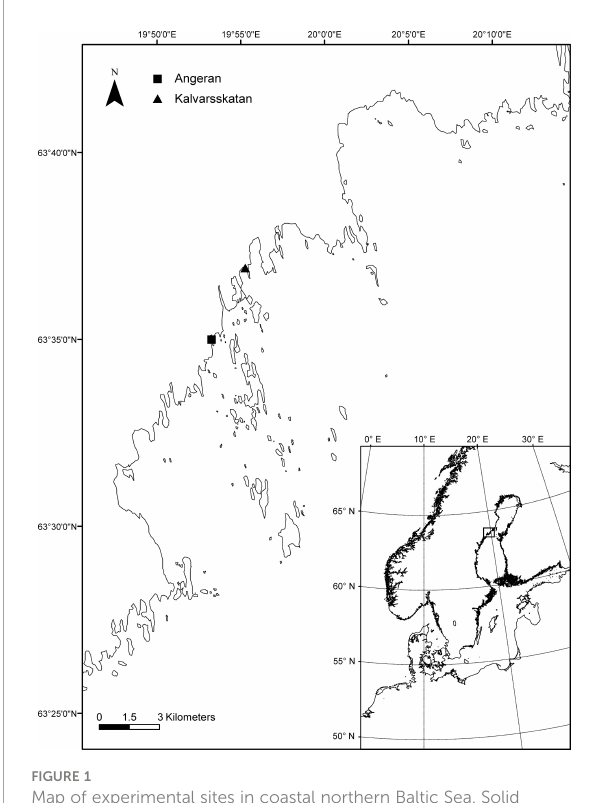
FIGURE 1 Map of experimental sites in coastal northern Baltic Sea. Solid triangle indicates site Kalvarskatan bay receiving no river in fl ow, and solid square indicates site Angeran bay receiving river in fl